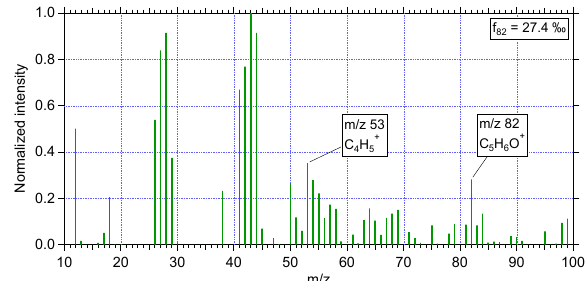
Figure 1. Normalized mass spectrum of IEPOX-SOA during flight AC13 conducted on 19 September 2014 at an altitude of 12.6km. Averaging time for this spectrum was 1min (15:54–15:55UTC). The two distinct IEPOX-SOA tracers m/z 82 and m/z 53 are la- beled. The calculated f 82 from this mass spectrum is